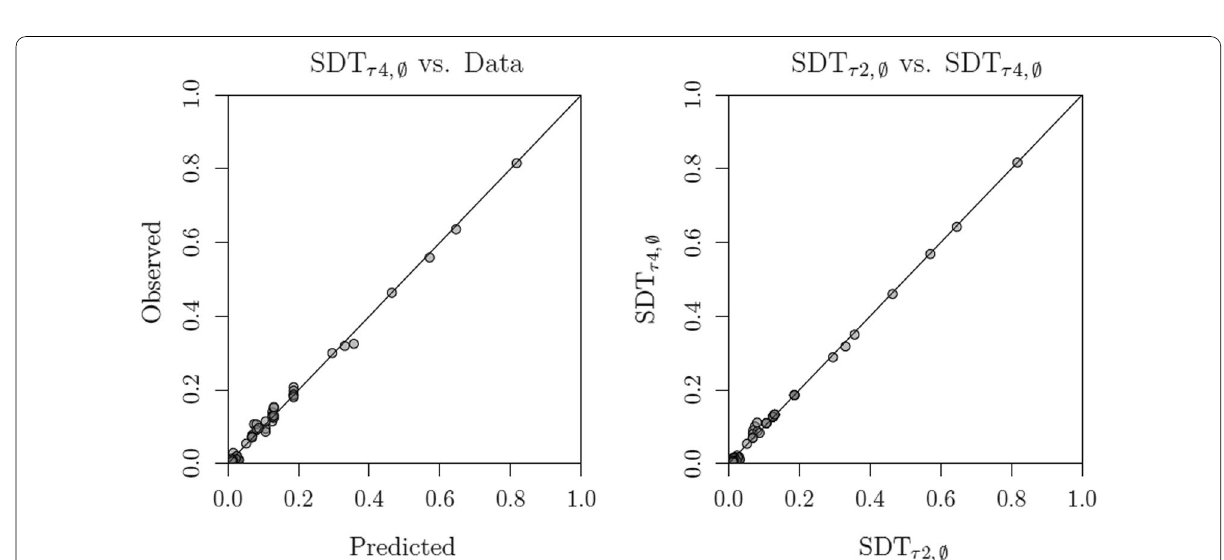
Fig. 6 Left panel: Comparison of model predictions (SDT τ 4, ∅ ) and the data. Right panel: Comparison of model predictions coming from the SDT τ 2, ∅ and SDT τ 4, ∅ models